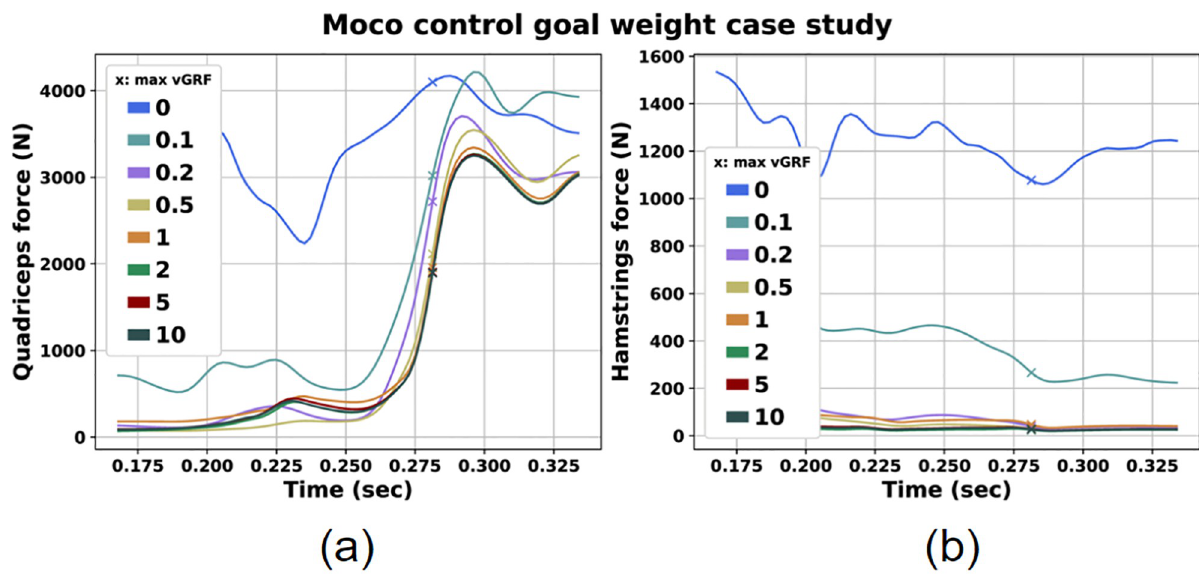
Fig 10. Quadriceps (a) and hamstrings (b) force for the Moco Control goal weight case study.